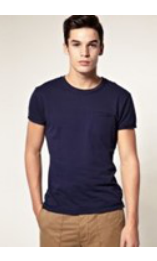
Fig. 5. Openpose input and